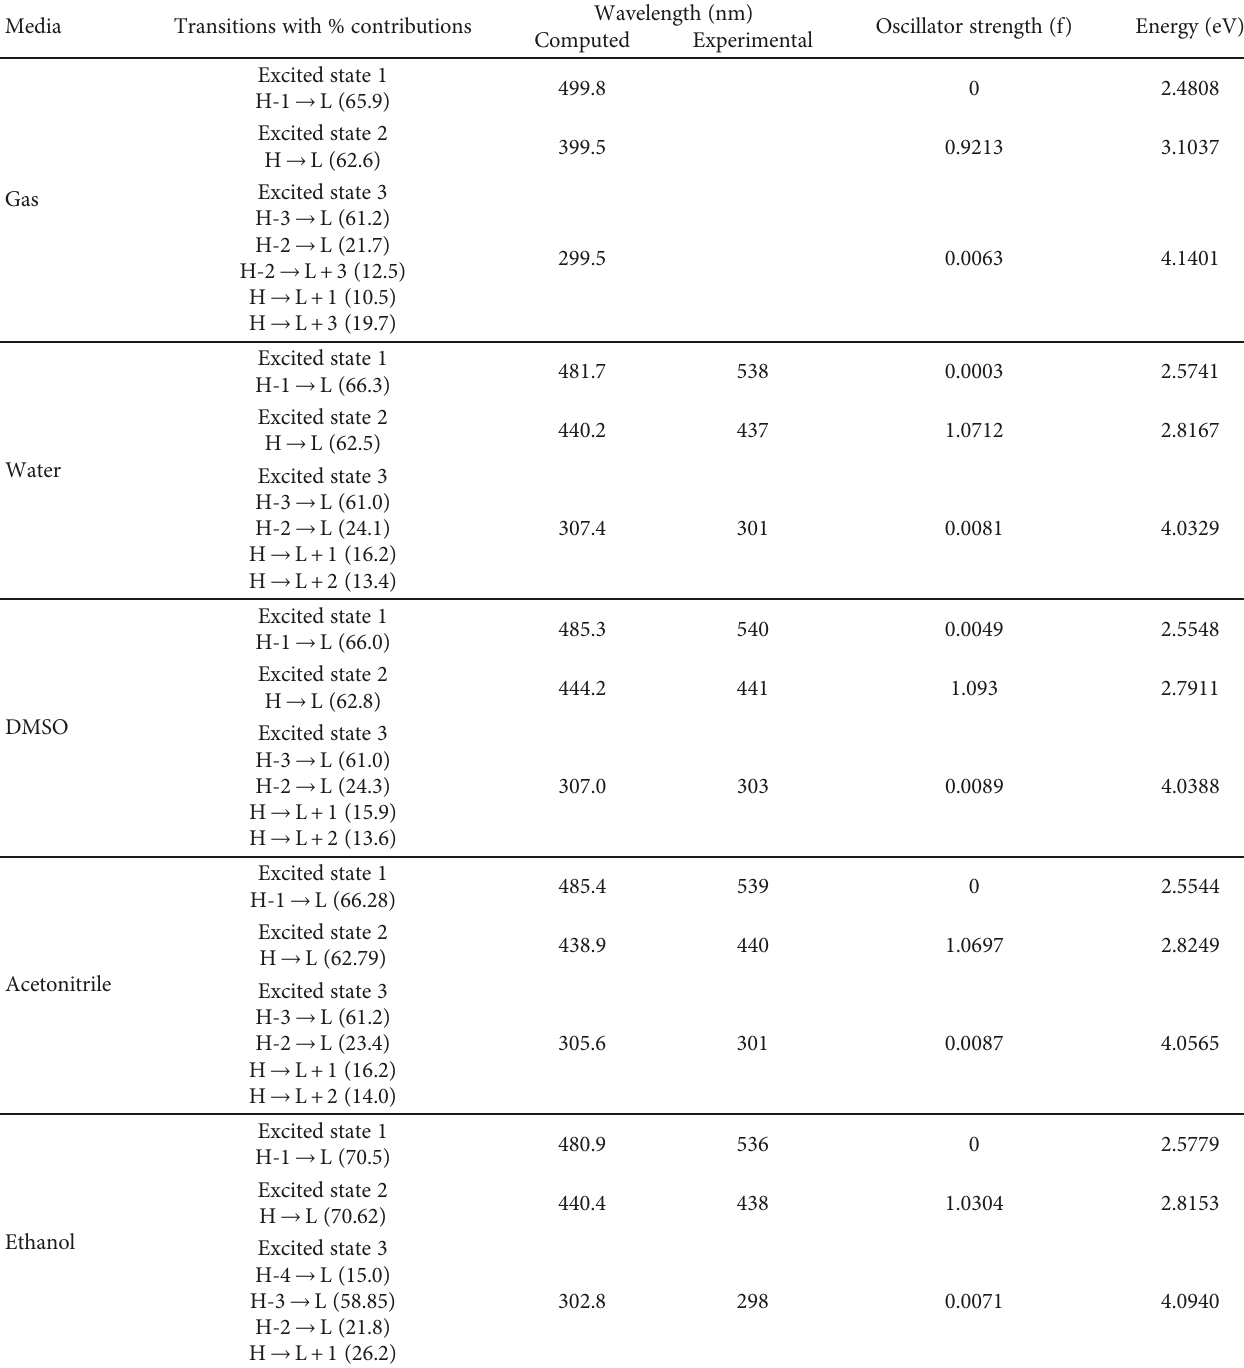
Table 5: Calculated and experimental electronic transition parameters of the DMAB by a B3LYP/6-311G++ method in gas and other